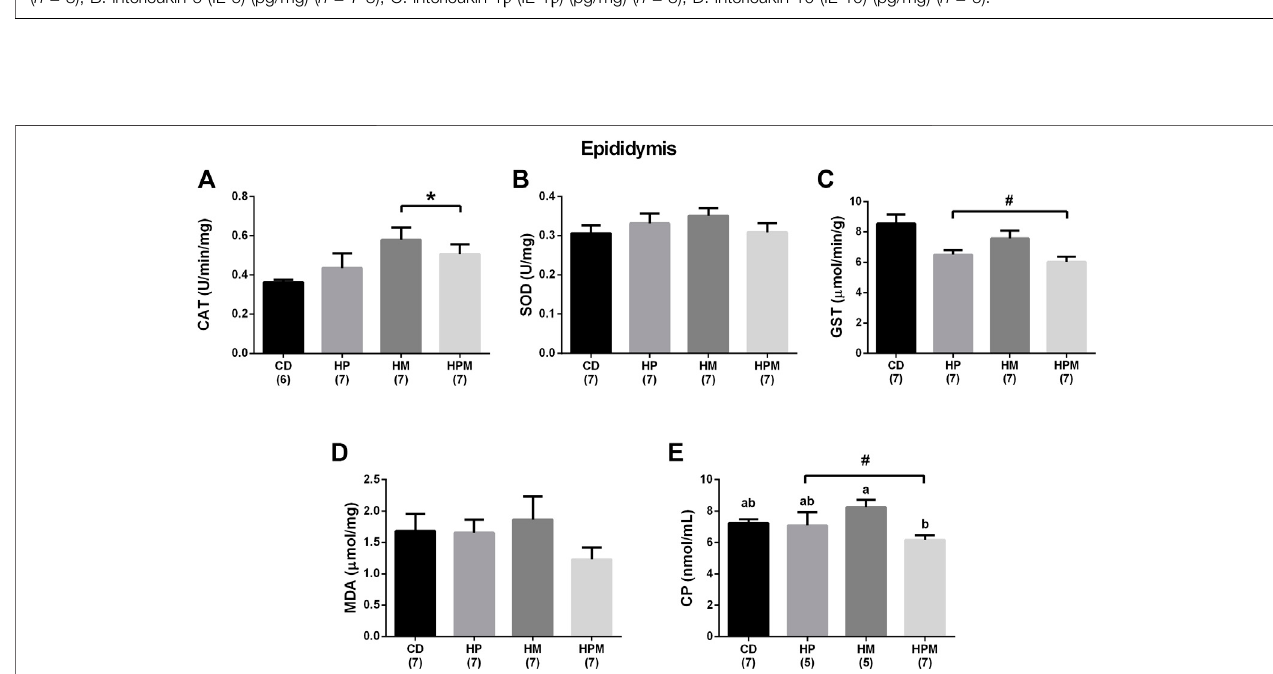
FIGURE7| Epidydimalantioxidantenzymeactivityandoxidativestressmarkersinmaleratoffspringfromprogenitorsfedonhigh-fathigh-sugardiet.Mean±SEM; symbols indicate signi fi cant difference caused by parental diet ( p < 0.05): # statistically signi fi cant by the effect of paternal diet; *statistically signi fi cant by the effect of maternaldiet.a,b Differentletters represent signi fi cantdifference between groups ( p < 0.05).H: high-fat and high-sugardiet; CD(controlpaternal and maternal diet), HP (H paternal diet and control maternal diet), HM (H maternal diet and control paternal diet) and HPM (H paternal and maternal diet). (A) : catalase (CAT) (U/min/mg) ( n = 6-7); (B) : superoxide dismutase (SOD) (U/mg) ( n = 7); (C) : glutathione S-transferase (GST) ( μ mol/min/g) ( n = 7); (D) : malondialdehyde (MDA) ( μ mol/mg) ( n = 7); (E) : carbonyl protein (CP) (nmol/mL) ( n = 5-7).